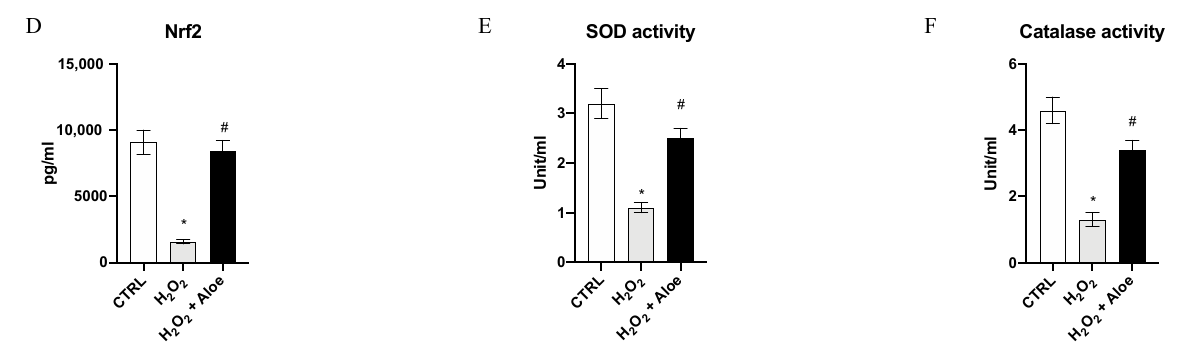
Figure 2. Effects of pre-treatment with aloe extract on Nrf2 ( A ), SOD2 ( B ), Catalase ( C ) mRNA expression. Effects of pre-treatment with aloe extract on Nrf2 levels ( D ), SOD activity ( E ), Catalase activity ( F ). Values are expressed as the means ± SD. * p < 0.0001 vs. CTRL; # p < 0.0001 vs. H 2 O 2 .